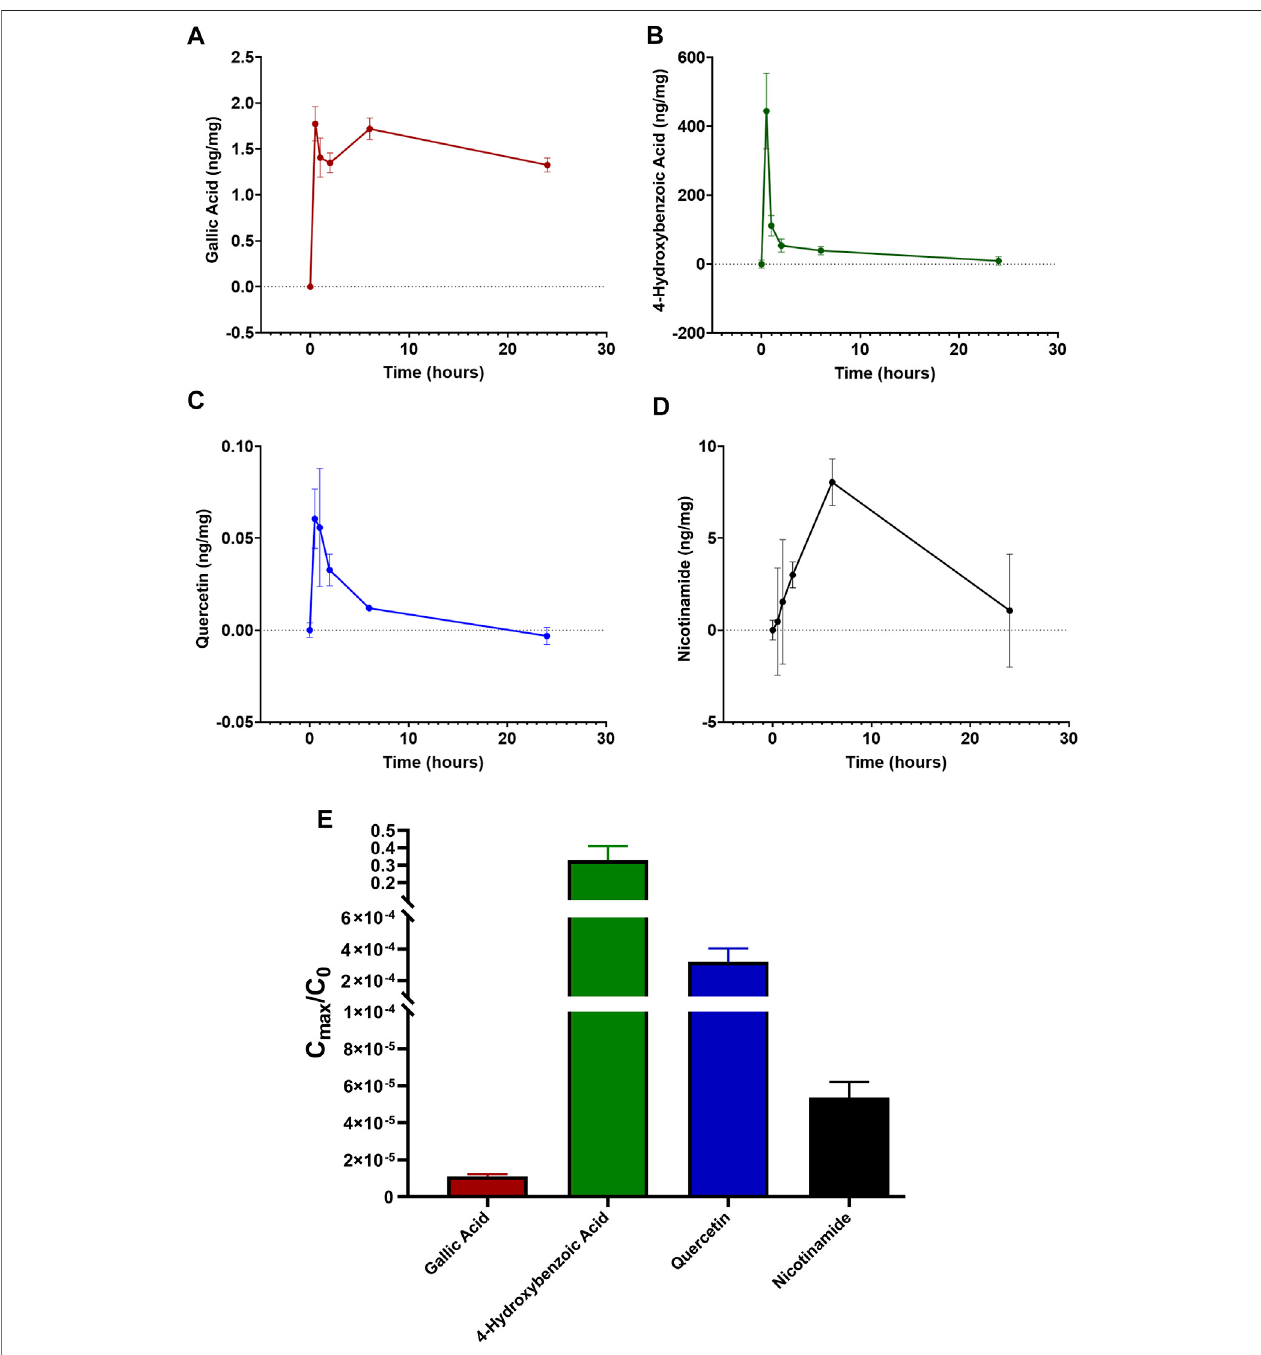
FIGURE7| Time-dependentretinalpro fi leofgallicacid (A) ,4-hydroxybenzoicacid (B) ,quercetin (C) ,andnicotinamide (D) amountafteradministrationof1 mgLG by oral gavage. (E) corresponding ratios calculated as the maximal amount of each compound reaching the retina (C max ) divided by the initial amount of the same compound administered in 1 mg of LG (C 0 ). Data are expressed as mean ± SEM of n (cid:1) 3 independent samples.